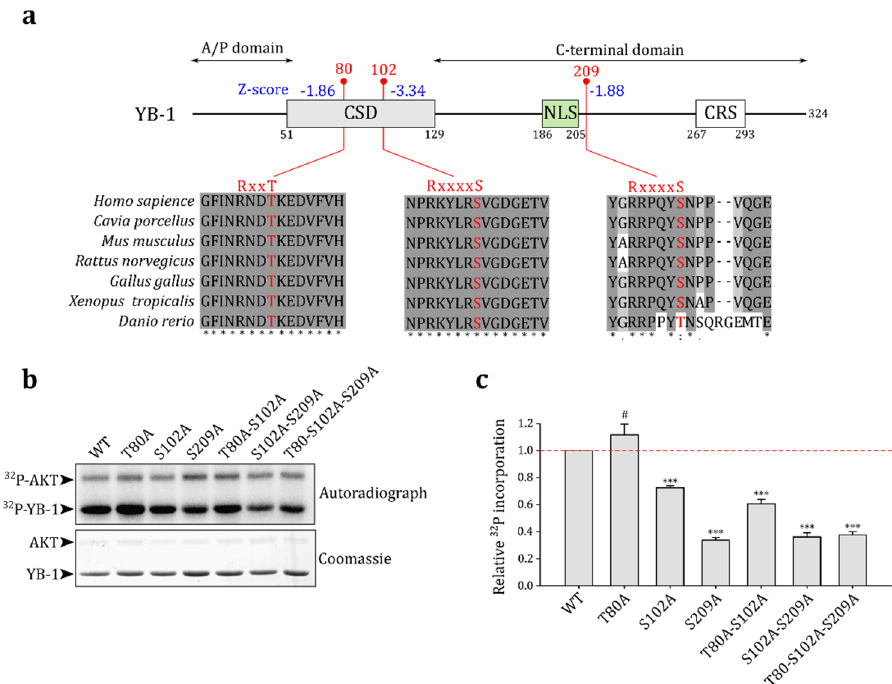
Figure 2. Akt phosphorylates S209 of YB-1 in vitro. ( a ) Schematic representation of predicted Akt phosphorylated sites in the YB-1 molecule (ScanSite Z-scores are indicated in blue). Positions of CSD (cold shock domain), NLS (nuclear localization signal), and CRS (cytoplasmic retention site) are shown as colored boxes. Vertebrate sequence alignments of particular segments of the YB-1 protein in the vicinity of phosphorylation sites are shown. Phosphorylation sites and Akt kinase consensus motifs are highlighted in red. ( b ) In vitro kinase assay for wild-type (WT) and mutant YB-1 proteins. The assay was performed by incubating 1 μ g of YB-1 with 0.25 μ g of activated Akt kinase in the assay buffer containing [ γ - 32 P]-ATP. The reaction products were analyzed by SDS-PAGE (Coomassie staining, bottom panel) and autoradiography (upper panel). ( c ) Quantification of in vitro kinase assay. The YB-1 phosphorylation level was normalized to that of the WT and corrected for the corresponding protein amount determined by Coomassie staining. The mean ± SD of four independent experiments is shown. #: non-significant, *** p < 0.001, one-sample t -test.